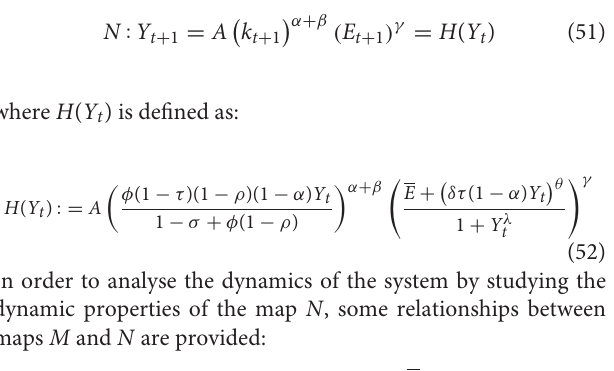
scale and constant social returns to scale, that is α + β ≤ 1.